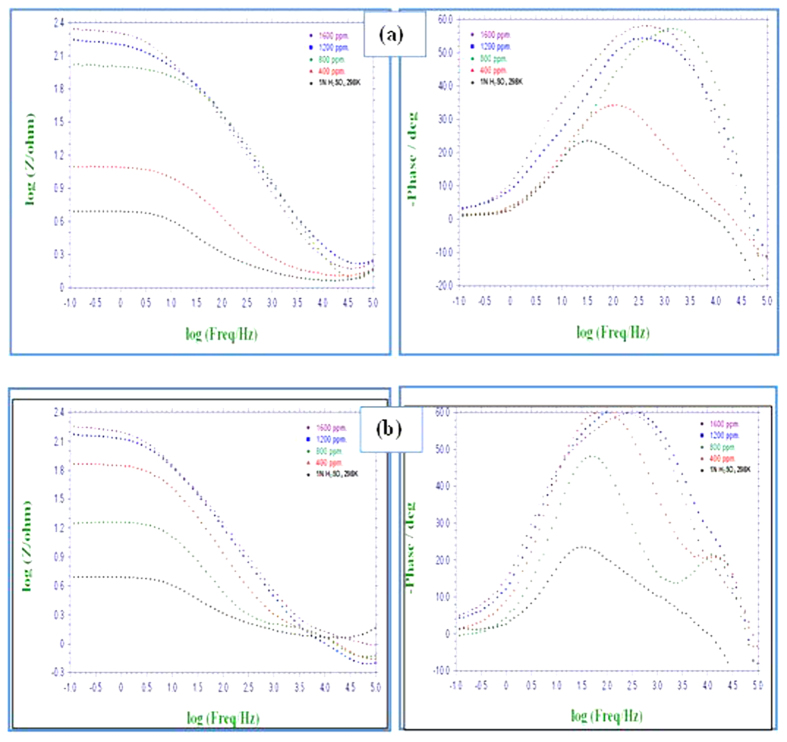
Bode plots for MS in 0.5 M H2SO4 without and with various concentrations of (a) PNVP-PU and (b) PDMAEMA-PU at 298 K.